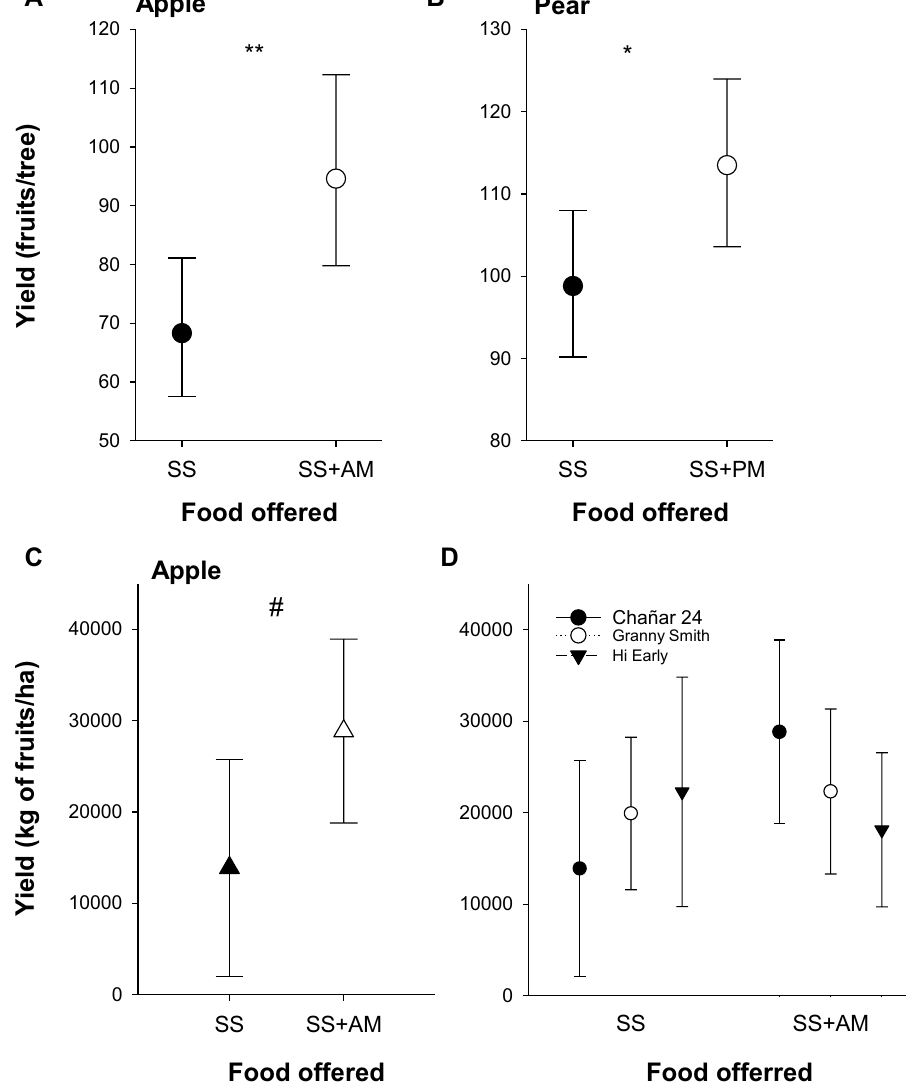
Figure 5. Effect of the offering of mimic-scented food on fruit yield and on plantation yield. ( A , B ) Yield was calculated as the counts of fruits per trees in a pair of apple plots and in a pair of pear plots, where 30 trees were surveyed in each. ( A ) Colonies that pollinate each apple plot were fed apple mimic-scented sucrose solution (SS + AM) or unscented sucrose solution (SS). ( B ) Colonies that pollinate each pear plot were fed pear mimic- scented sucrose solution (SS + PM) or unscented sucrose solution (SS). ( C , D ). Yield was obtained either from 11 apple plots (varieties: Hi Early, Granny Smith and Chañar 28) that settle 130 colonies in total that had been fed apple mimic-scented sucrose solution (SS + AM) and from 11 apple plots (varieties: Hi Early, Granny Smith and Chañar 28) with 139 colonies that had been fed unscented sucrose solution (SS). Yields are presented for all apple varieties together ( C ) or separately ( D ) Asterisks indicate significant differences between the treatments (*, p < 0.05; **, p < 0.01; # , p = 0.06). Circles indicate the mean values and bars show the 95% confidence intervals. Package ‘ml’, version 60 . Package ‘emmeans’, version 1.8.0. https:// github. com/ rvlen th/ emmea